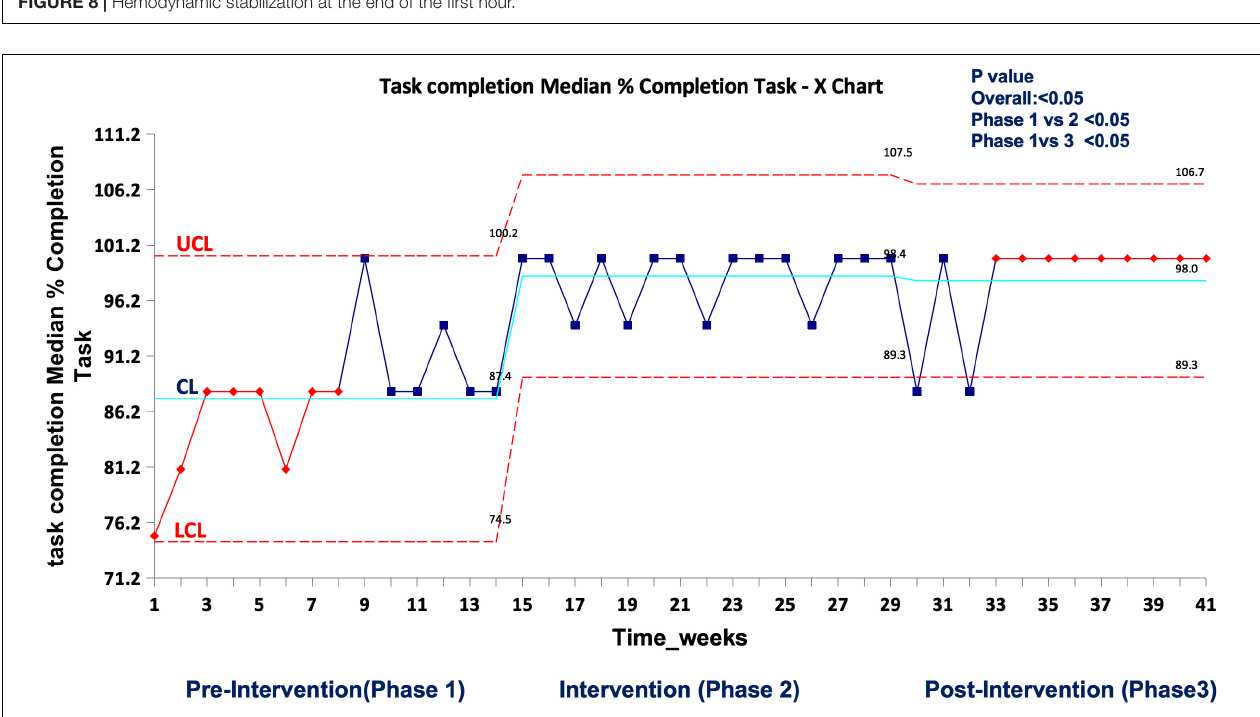
FIGURE 9 | Median percent completion of task as per checklist during the first-hour management of shock in real patient events in the emergency room. UCL, upper control limit; CL, center line; LCL, lower control